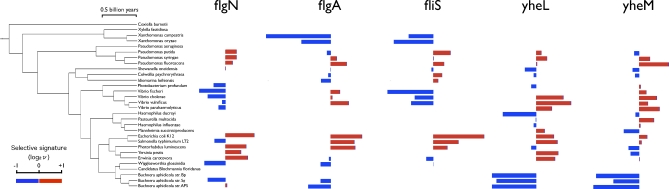
Genes of Common Function Have Similar Selective SignaturesRelative rates of evolution are shown for five genes across 30 species. Fast-evolving genes (log2ν > 0) are shown as red bars; slow-evolving genes (log2ν < 0) as blue bars; genes absent in a given species are not shown. The time scale for the phylogeny was estimated using a Bayesian relaxed molecular clock model [52]. Flagellar genes: flgN (COG 3418; Flagellar biosynthesis/type III secretory pathway chaperone), flgA (COG 1261; Flagellar basal body P-ring biosynthesis protein), fliS (COG 1516; Flagellin-specific chaperone). Sulfur metabolism genes: yheL (COG 2168; Uncharacterized conserved protein involved in oxidation of intracellular sulfur), yheM (COG 2923; Uncharacterized conserved protein involved in oxidation of intracellular sulfur).